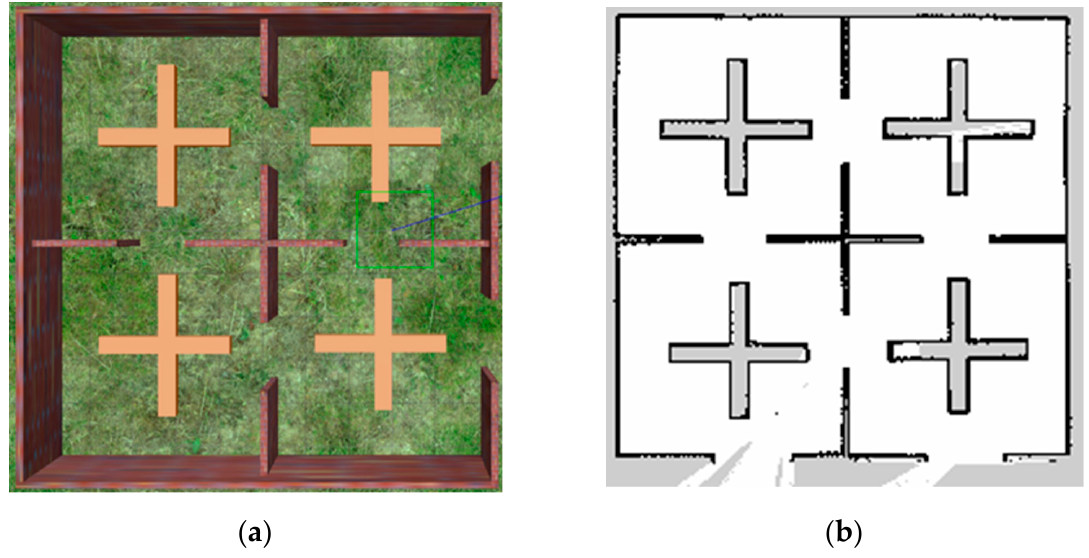
Figure 9. Map modeling and simulation map: ( a ) map modeling; ( b ) simulation e ff ect map.